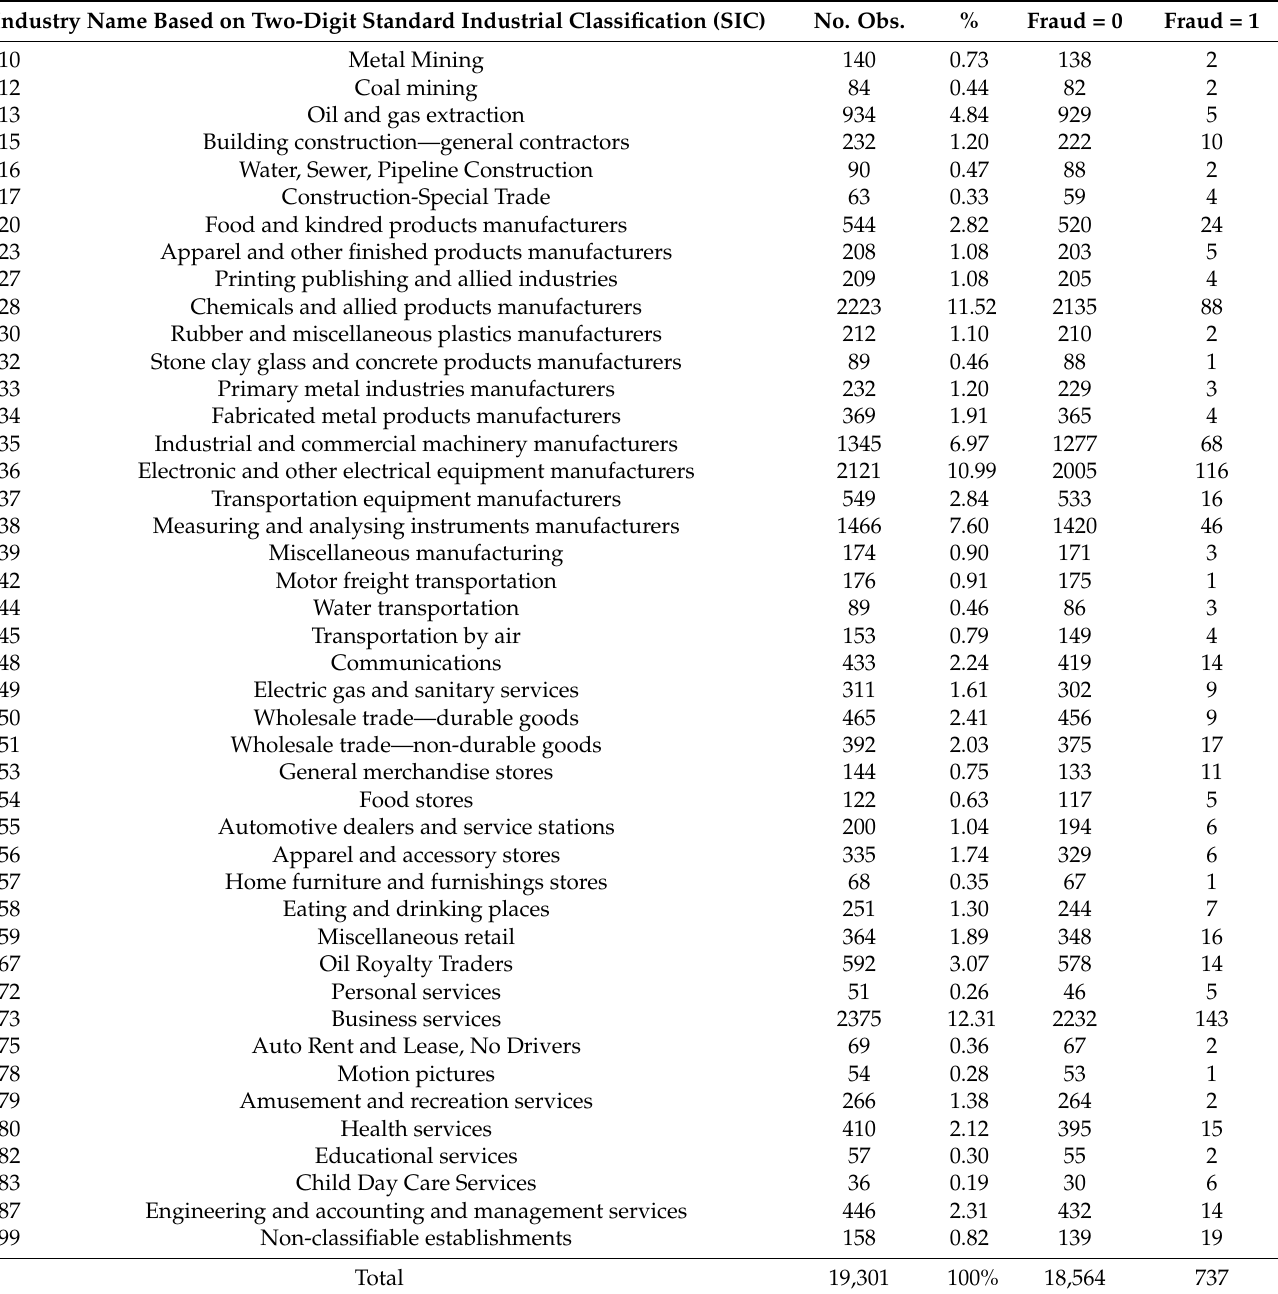
Table 2. Firms distribution by industry codes for fraud and non-fraud